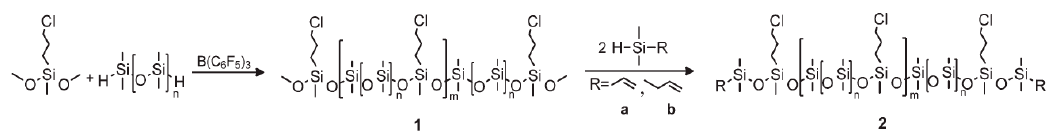
Figure 3. Synthesis of chloropropyl linear polysiloxanes by the PR reaction (Reproduced from Reference [13] published by The Royal Society of Chemistry).